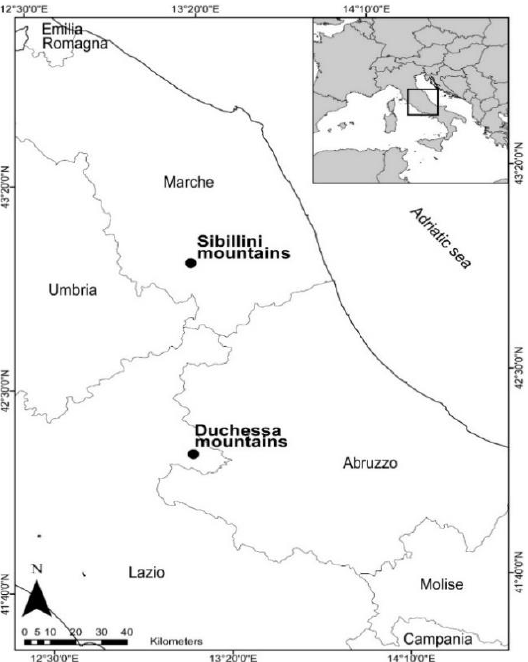
Figure 1. Location of the two montane beech forest in the Apennines in Central Italy: Sibillini (Marche Region) and Duchessa (Lazio Region).